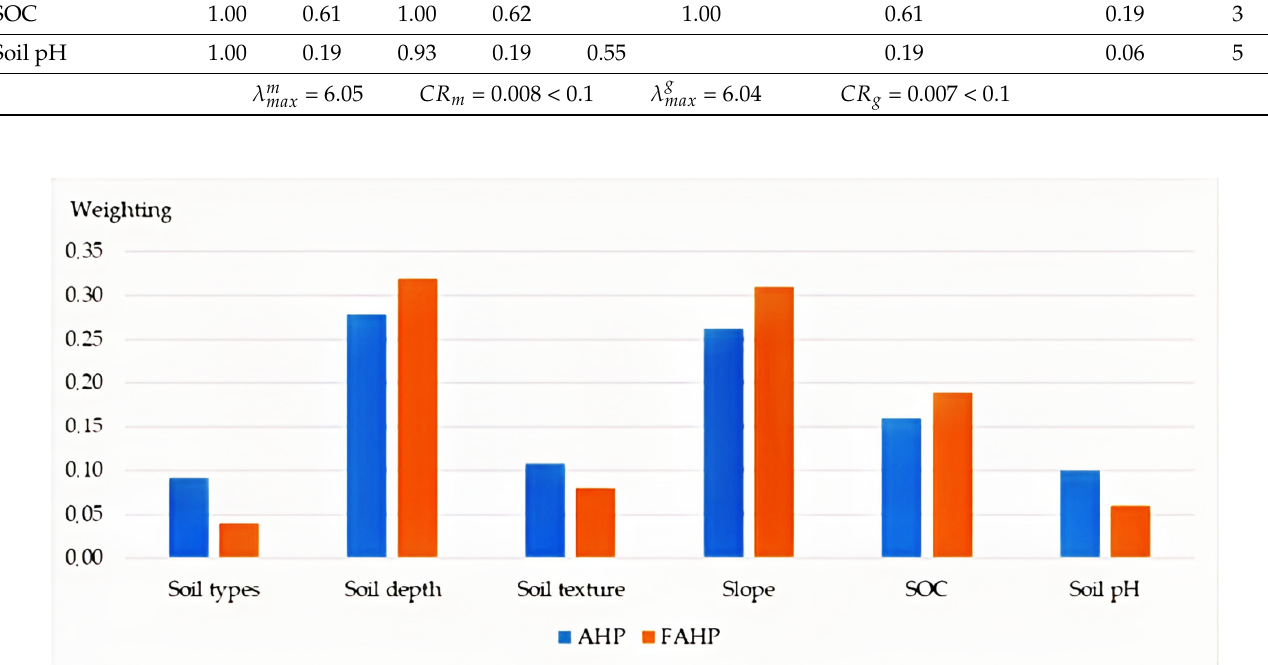
Figure 4. The differences in criteria weighting by AHP and FAHP. Table 6. The pairwise comparison matrix and criteria weight by AHP method.